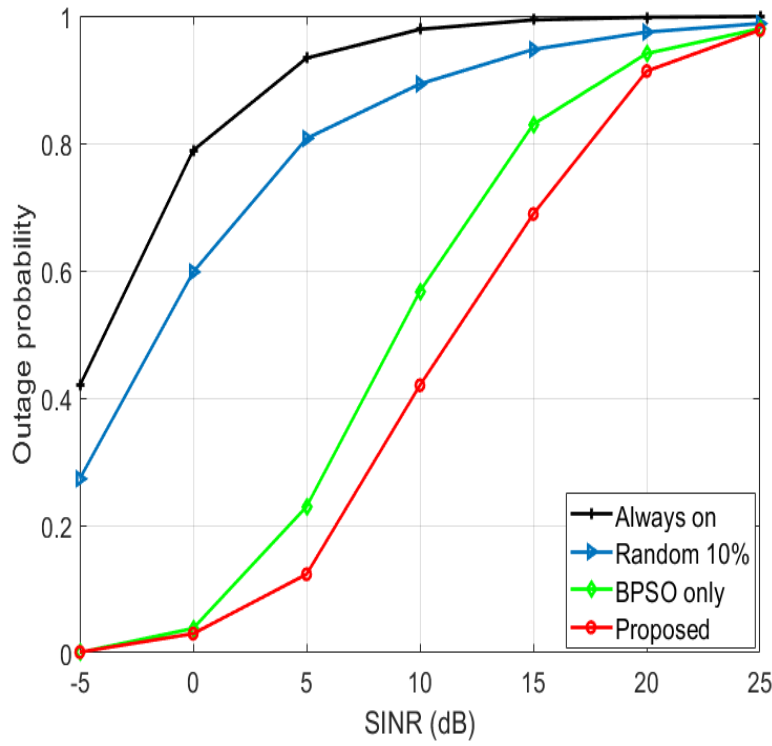
Figure 10. Outage probability for various SINR thresholds in the case of 900 UEs.